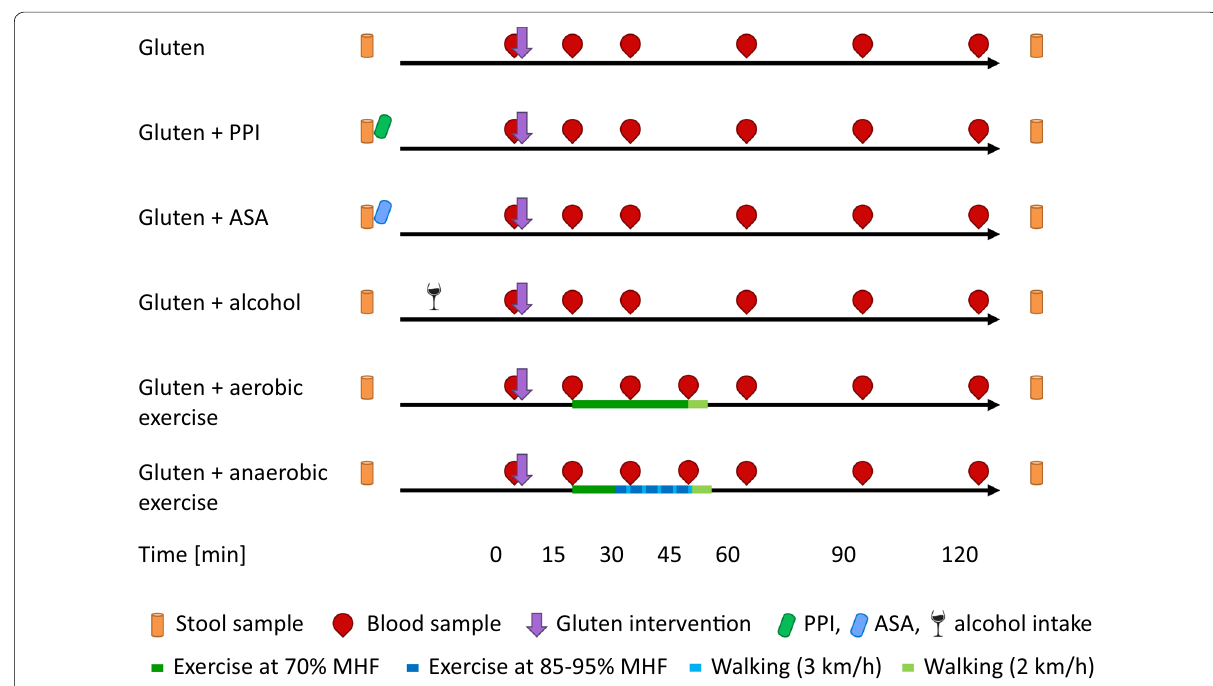
Fig. 1 Study design and challenge protocol. ASA acetyl salicylic acid, MHF maximal heart frequency, PPI proton pump